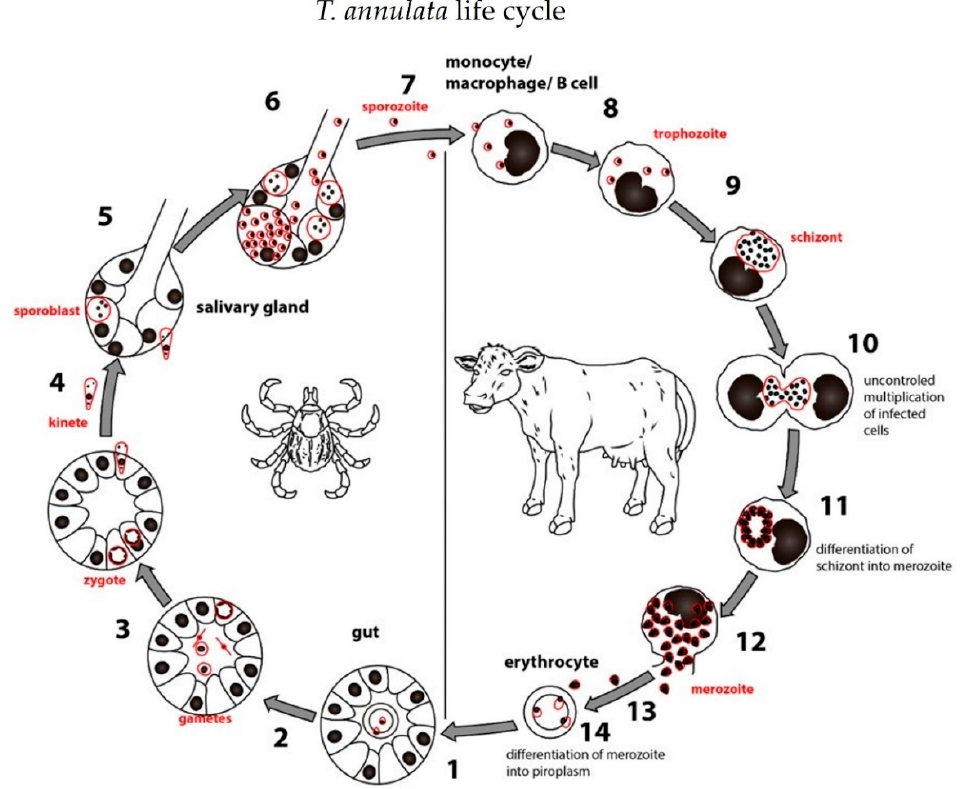
Figure 1. T. annulata life cycle as an example of the general life cycle of Theileria spp. Source: Andrade, et al [44] (Reprinted/adapted with permission from Ref. [44]. 2019, Pedro